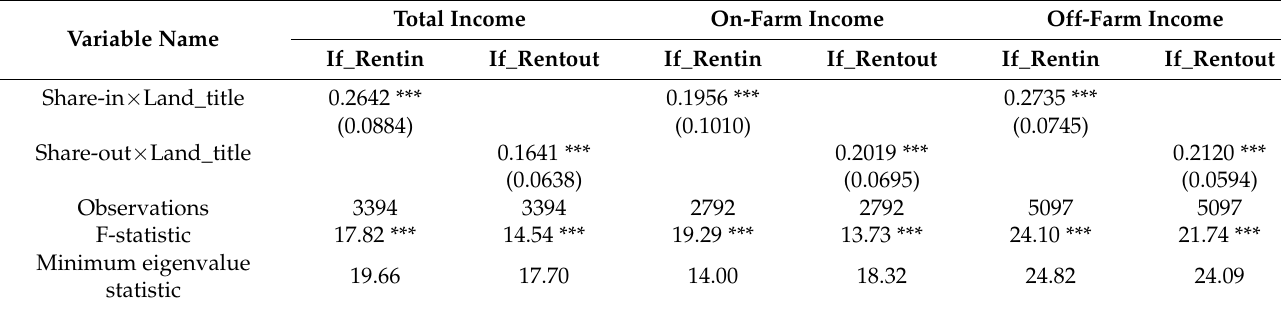
Table 3. 2SLS first-stage regression